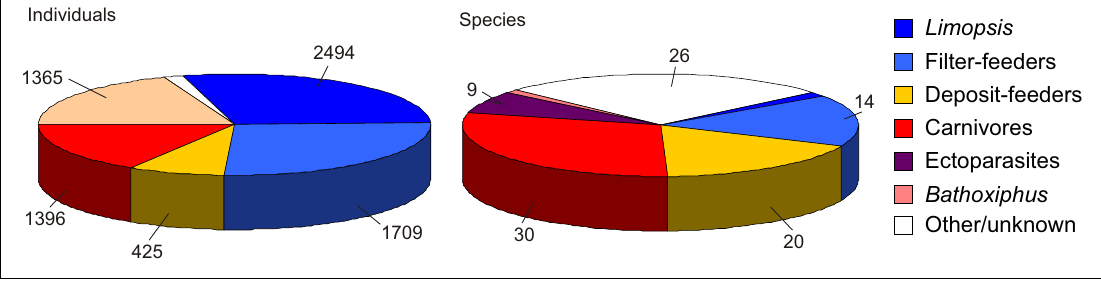
Fig. 46. Percentage of the different trophic groups, in number of live-taken individuals (left) and species represented by at least one live-taken specimen